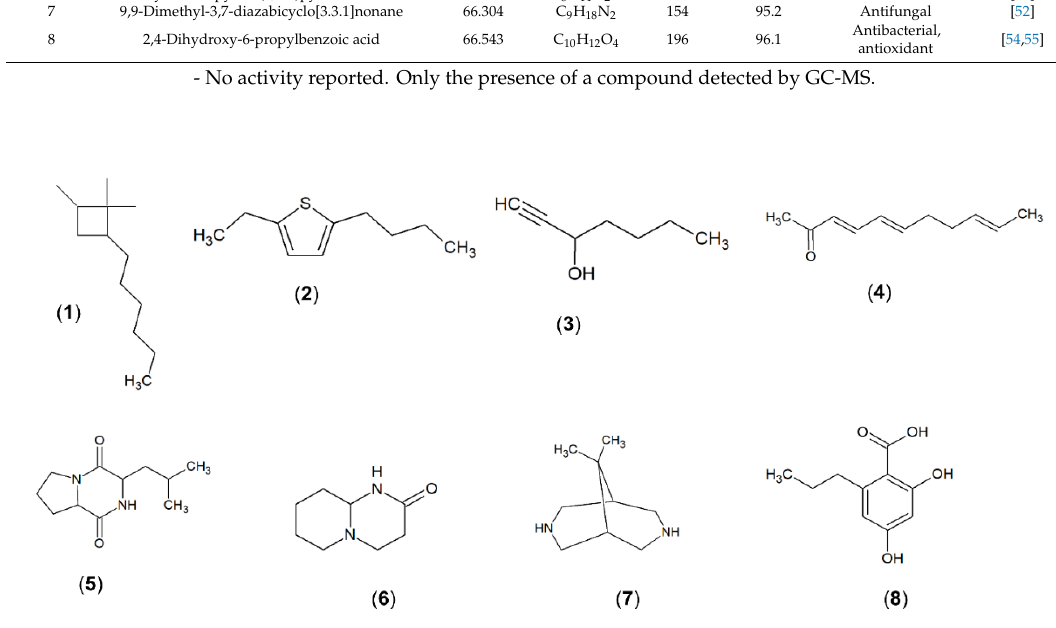
Figure 3. Chemical structures of compounds detected in the methanolic extract strain MUSC 125.